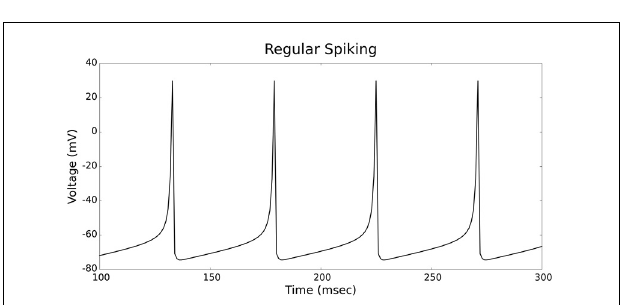
FIGURE 5 | IZH neuron model: regular spiking firing patterns.